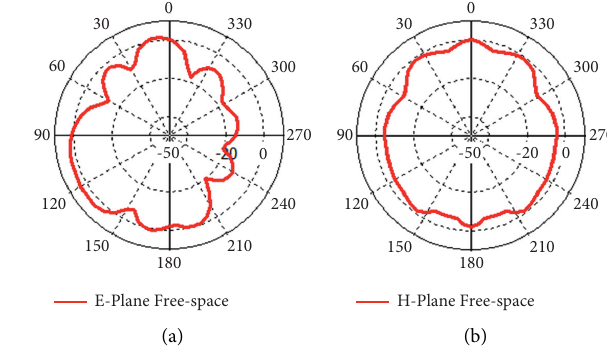
Figure 12: Radiation pattern of Array 2. (a) E-plane radiation pattern at 60GHz. (b) H-plane radiation pattern at